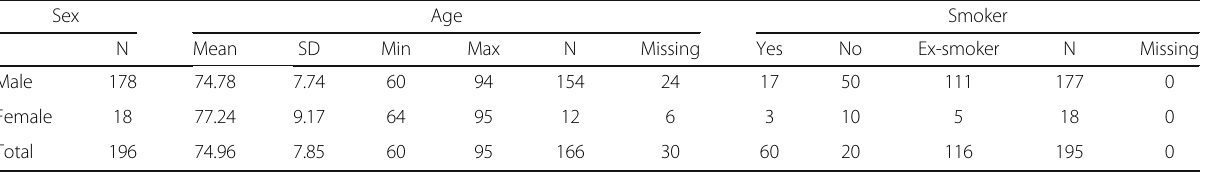
Table 1 Participant gender, age and smoking status